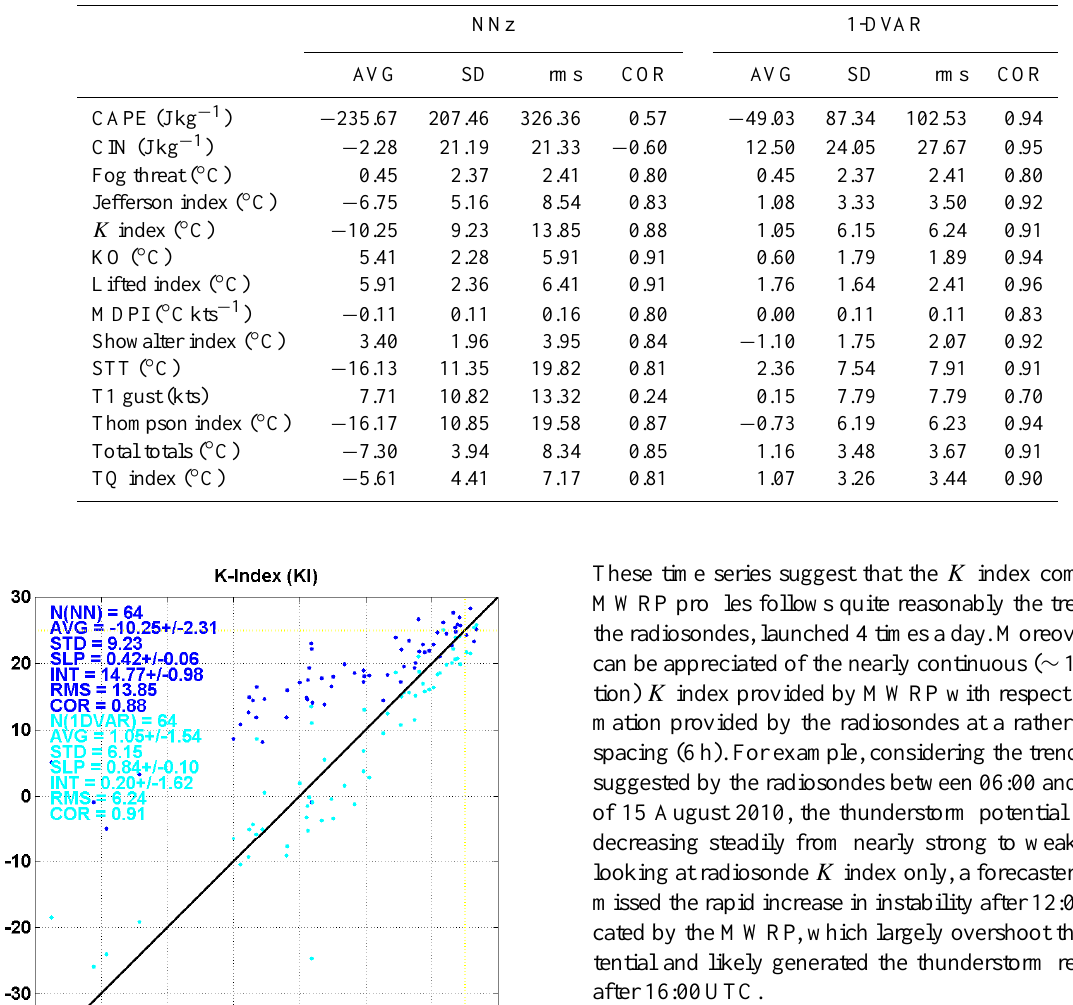
Table 2. Statistics of the difference between FIs computed from radiosonde and MWRP retrievals (NNz and 1-DVAR) in Whistler (64 radiosondes). Here are shown average (AVG) FI difference (radiosonde–MWRP), standard deviation (SD), root mean square (rms), and correlation coefficient (COR).